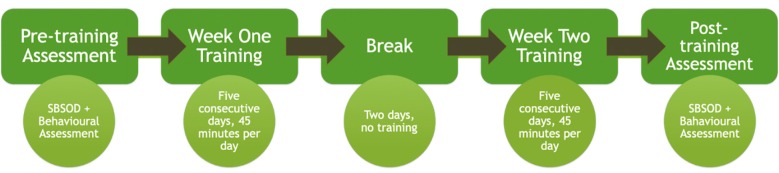
Timeframe of the training protocol across a 12-day period.